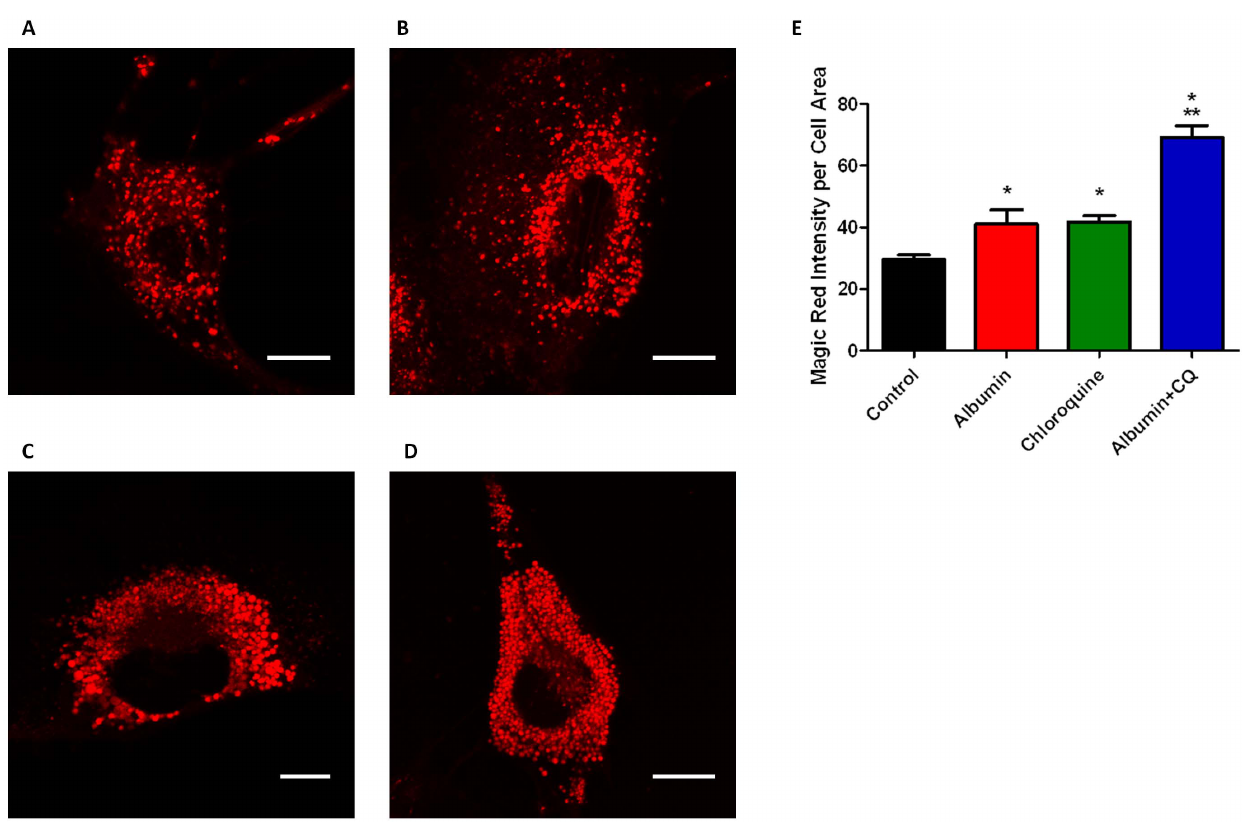
Figure 3. Exposure of podocytes to albumin and chloroquine increased lysosome fluorescence. Representative individual podocytes are shown for A ) negative control B ) albumin (5 mg/mL) exposure for 24 h C ) chloroquine (50 m M) exposure for 24 h D ) albumin (5 mg/mL) + chloroquine (50 m M) exposure for 24 h. After treatment with Magic Red Cathepsin B, individual lysosomes fluoresce red in the presence of active cathepsin B. E ),Exposure to albumin and chloroquine increased the density of lysosome fluorescence. The effect was potentiated in podocytes exposed to both albumin and chloroquine. Fluorescence is expressed in arbitrary units. Scale bar is 20 m m. (n=8 for all treatment groups, * p , 0.05 vs control. **p , 0.05 vs albumin or chloroquine